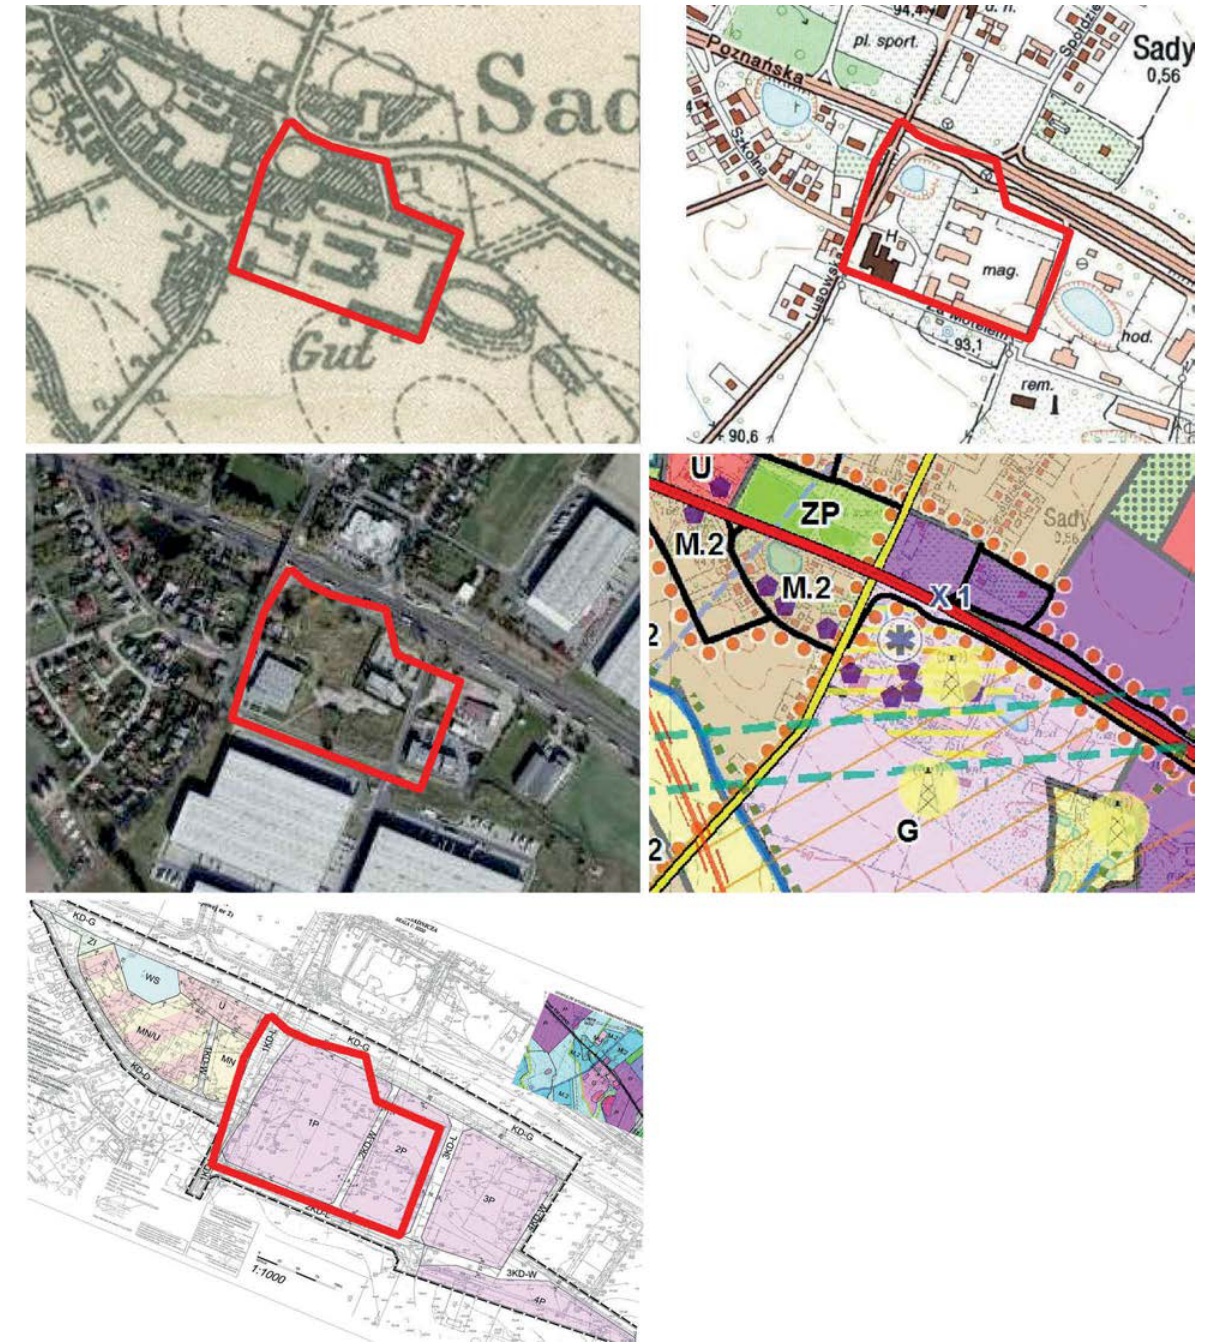
Fig. 5. Spatial arrangement of the nonexistent grange complex at Sady in the 1940s and 1970s and the present state of the complex on an orthophoto map (the range of the complex is marked with a red line), the conservation zone delineated for the complex in the Land Use Plan (yellow horizontal lines) and an extract from a drawing in the local spatial development